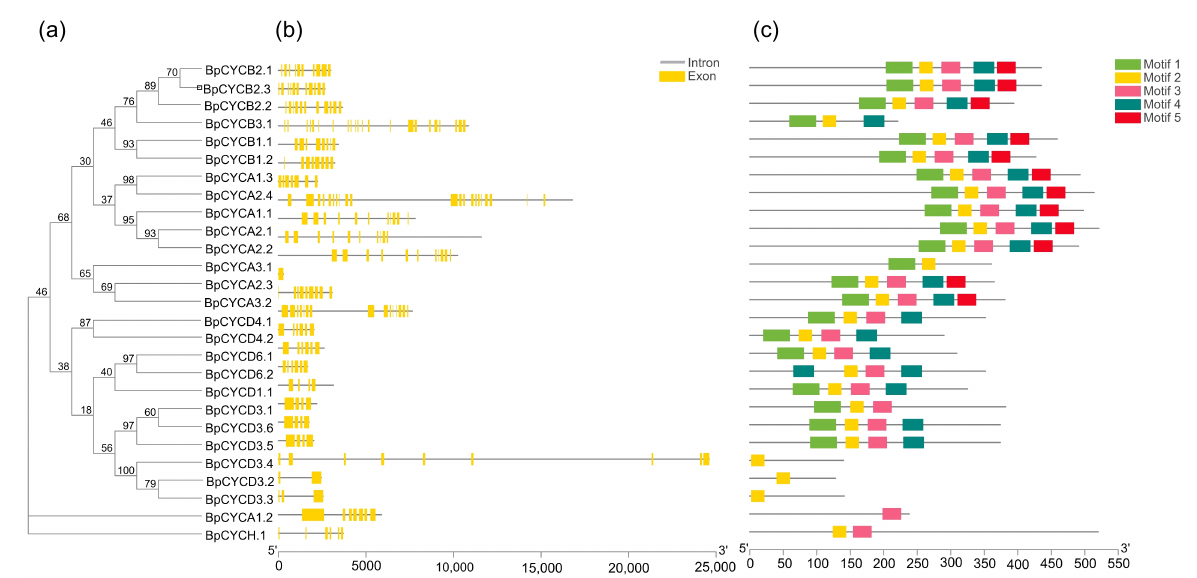
Figure 3. Phylogenetic analysis; exon/intron genomic structure and protein motif organization of CYC in B. pendula . An unrooted phylogenetic tree was constructed using MEGA5.05 by the neighbor-joining method. Gene structure of the corresponding BpCYCs genes, TBtools software was used to visualize gene structure. The yellow boxes represent exons and grey lines represent introns. Use MEME web server to analyze the distribution of conserved motifs in BpCYCs protein. The protein motif figure of BpCYCs was constructed by TBtools software. ( a ) Phylogenetic analysis of BpCYCs; ( b ) exon/intron genomic structure of BpCYCs ; ( c ) protein motif organization of BpCYCs.